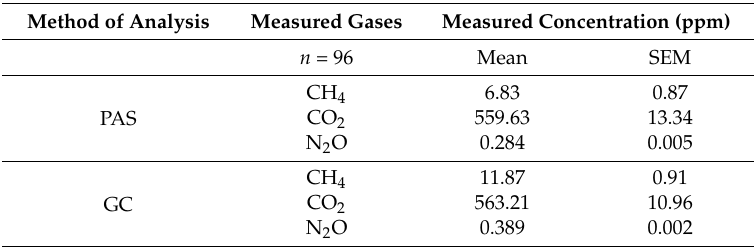
Table 2. Analysis of gas concentrations using the PAS and GC techniques.